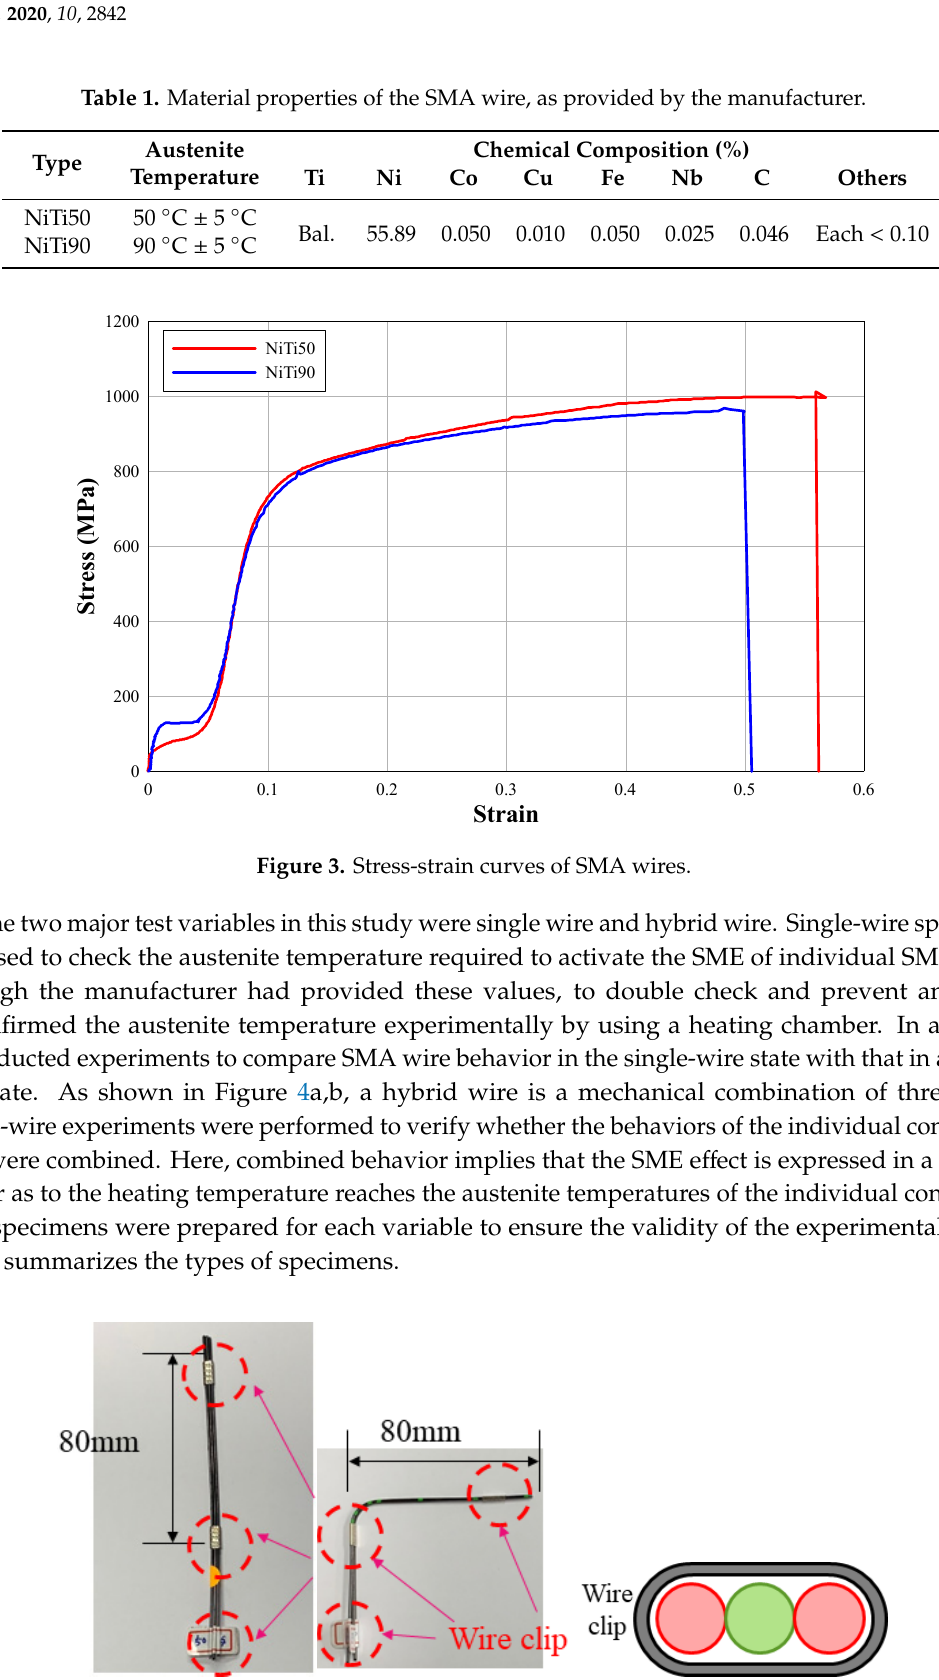
Figure 4. Details of specimens: ( a ) unbent hybrid SMA wire and bent hybrid SMA wire; ( b ) section of specimen at wire clip.